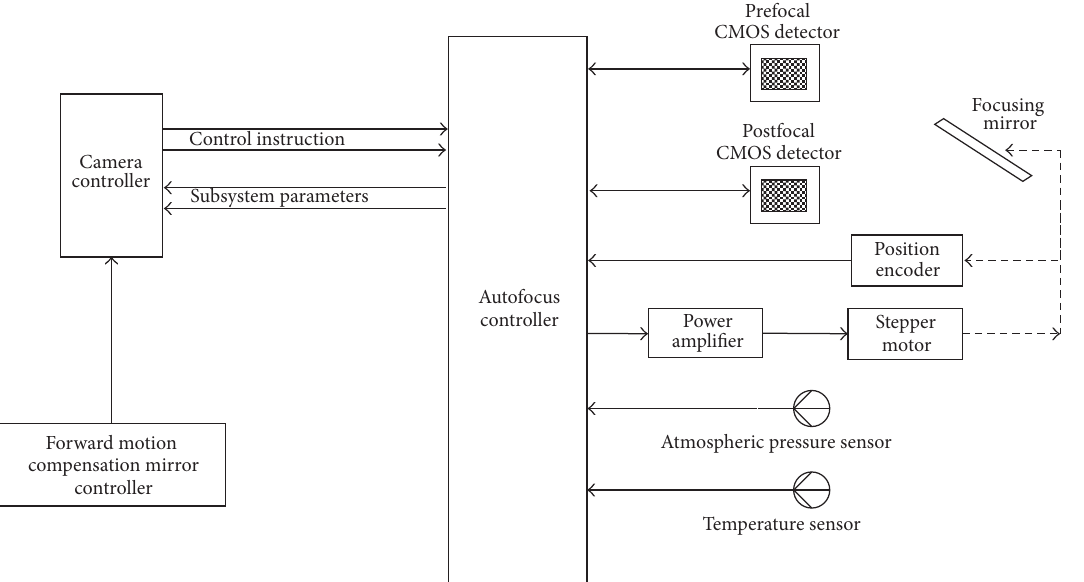
Figure 4: Framework for the autofocusing